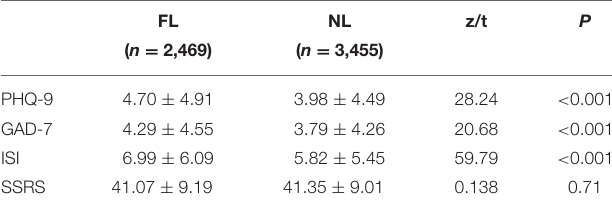
TABLE 2 | The scores of each scale of FL and NL and their